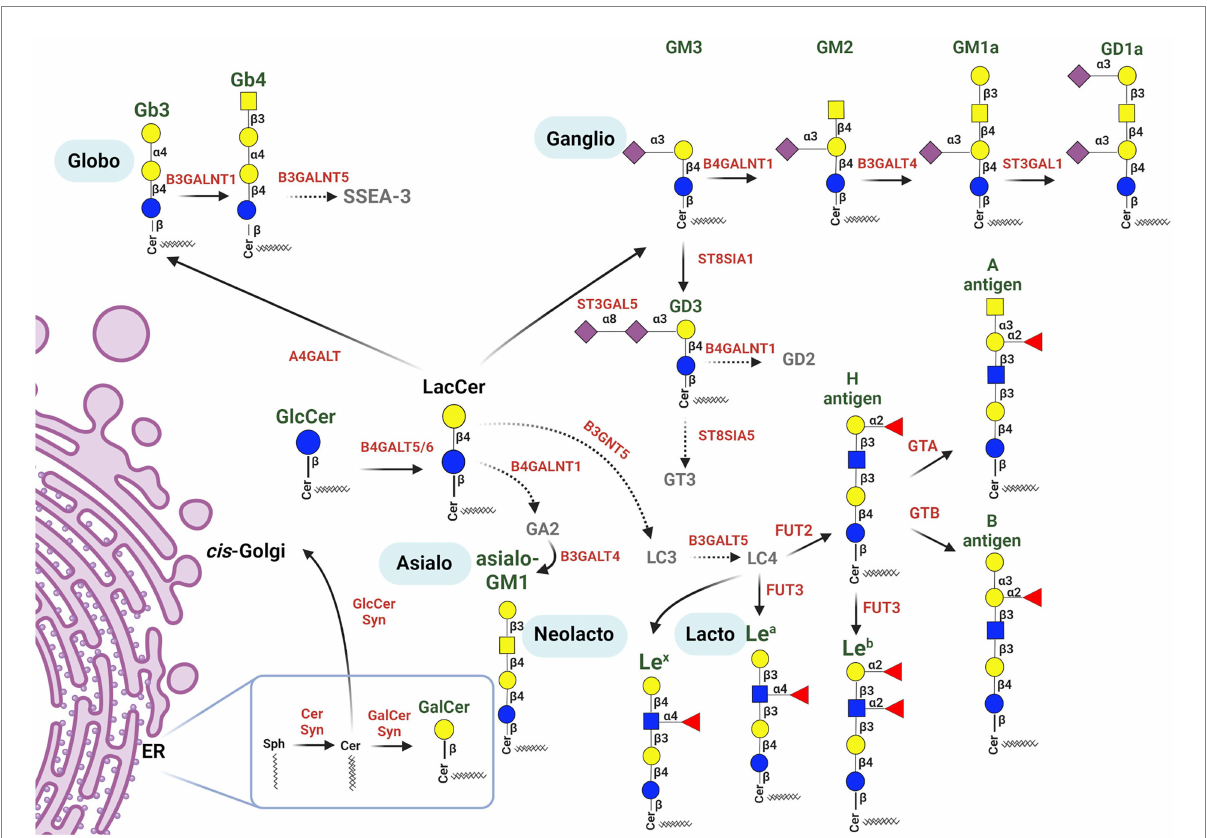
FIGURE 2 Schematic representation of major glycosphingolipid biosynthesis pathways, highlighting GSLs participating in pathogen binding. Biosynthesis of GSLs proceeds in the endomembrane system, beginning in the endoplasmic reticulum by ceramide synthesis from sphingoid base and acyl-CoA, and continues in the Golgi apparatus. Ceramide may be galactosylated in the ER (producing GalCer) or transported to the cis -Golgi to produce GlcCer and LacCer. LacCer is used for the production of more complex GSLs by specific Golgi-resident glycosyltransferases, creating several GSL series pathways. LacCer is utilized by (1) β 1,4- N -acetylgalactosylaminyltransferase (B4GALNT1) initiating the asialo series; (2) β 1,3- N - acetylglucosaminyltransferase (B3GNT5), producing Lc3, which is converted to Lc4, the precursor for the lacto and neolacto series GSLs; (3) α 1,4- galactosyltransferase (A4GALT), producing Gb3, thus initiating the globo series pathway; (4) α 2,3-sialyltransferase (ST3GAL5), producing GM3, which belongs to the ganglio series. The ABO histo-blood group antigens are subsequently formed from the H antigen (it is also the precursor of the Le b antigen, belonging to the Lewis blood group system) by specific GTs; α 1,3- N -acetylgalactosyltransferase (A transferase) synthesizes the A antigen, while α 1,3-galactosyltransferase (B transferase) synthesizes the B antigen. The Le a and Le x blood group antigens are created by fucosyltransferase 3. More complex glycan structures of ganglio-series GSLs are formed by a sequential action of different GTs, such as N -acetylg alactosaminyltransferases, galactosyltransferases and sialyltransferases, producing the GM2, GM1a and GD1a gangliosides. GM3 may be further processed by α 2,8-sialyltransferase 1, forming GD3. GSLs in green play roles in interactions with pathogens. Glycosyltransferases involved in GSL synthesis are shown in red [Figure was created with